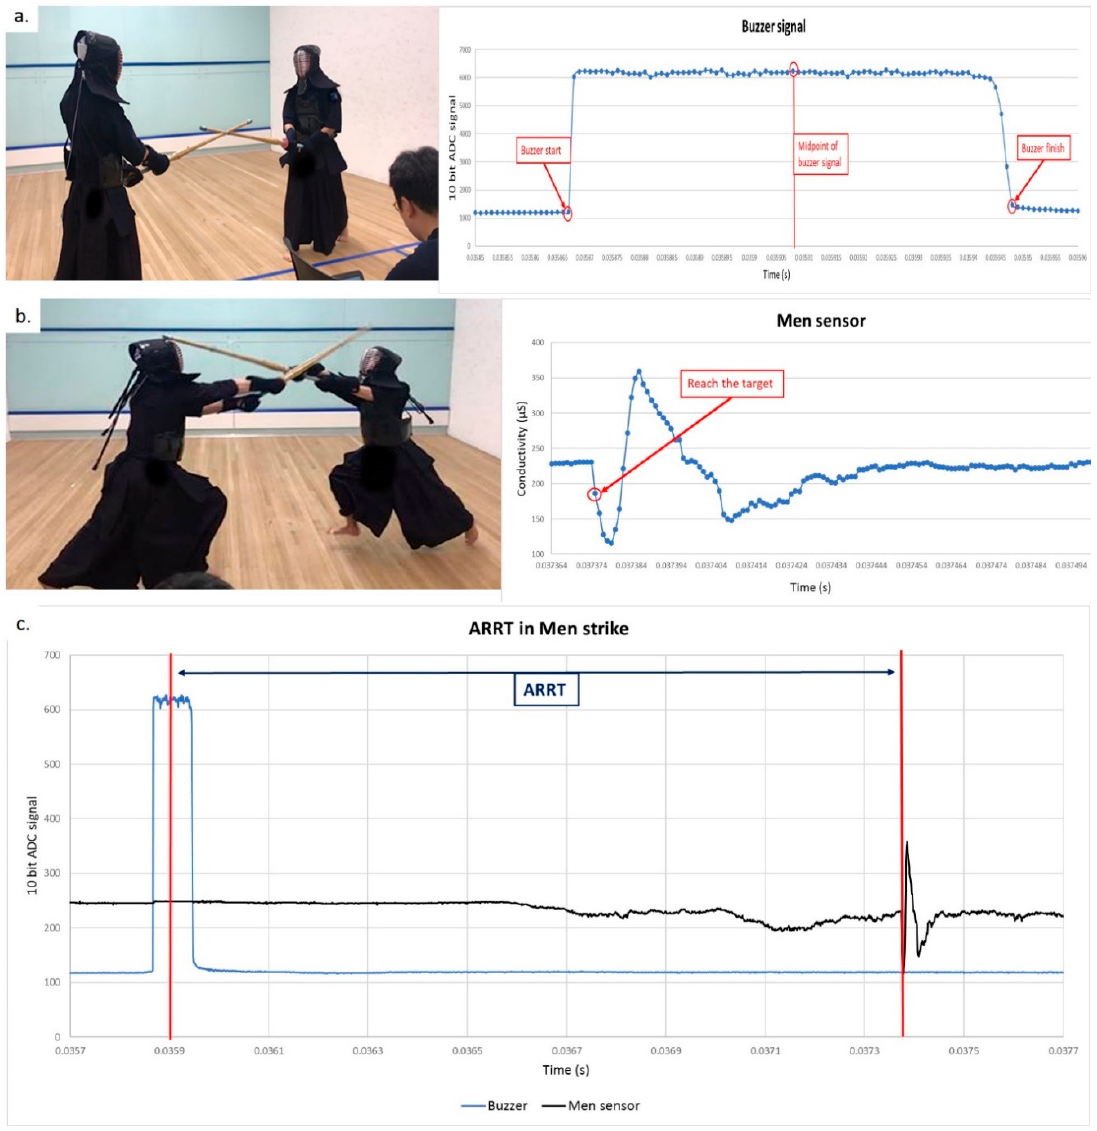
Figure 1. ( a ) Midpoint of buzzer signal; ( b ) the signal of Men sensor; ( c ) the example of auditory response reaction time (ARRT) in Men